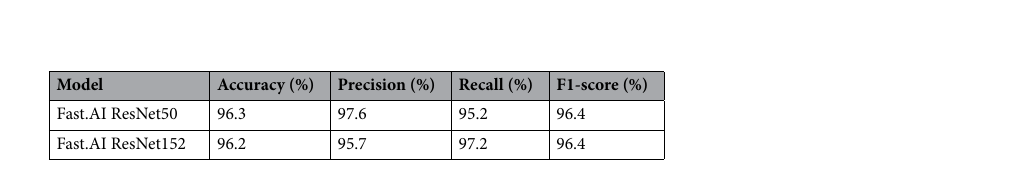
Table 5. Results of CNN models with Fast.AI.